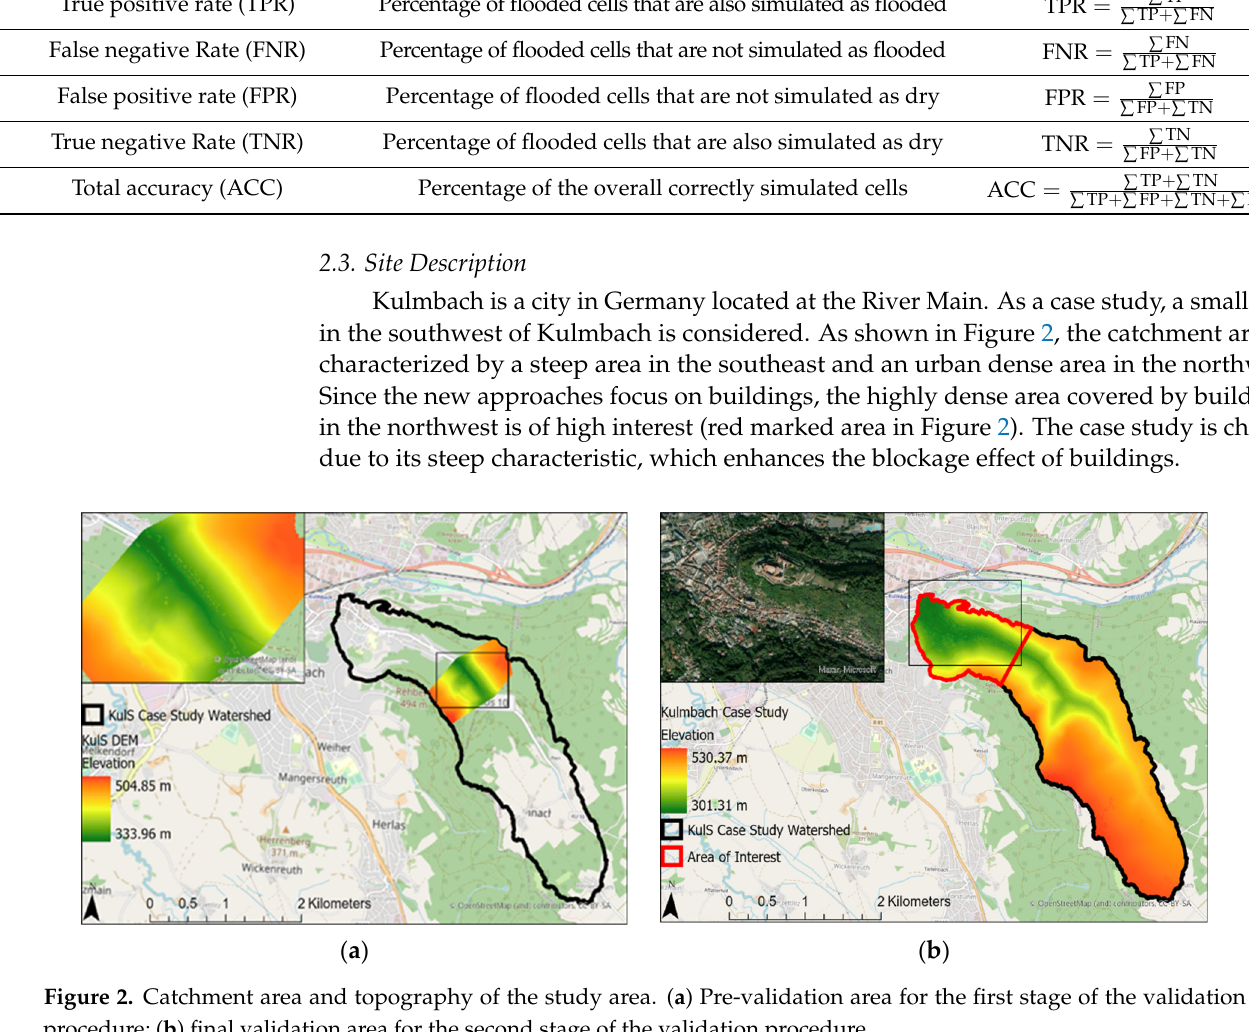
Table 2. Determined terms by means of the confusion matrix.